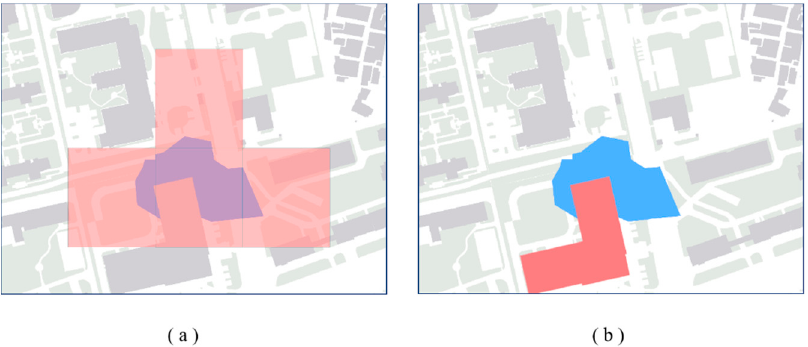
Figure 10. Underestimation of the affected population: ( a ) using WorldPop grid to assess the affected population and ( b ) using the redistributed building population.